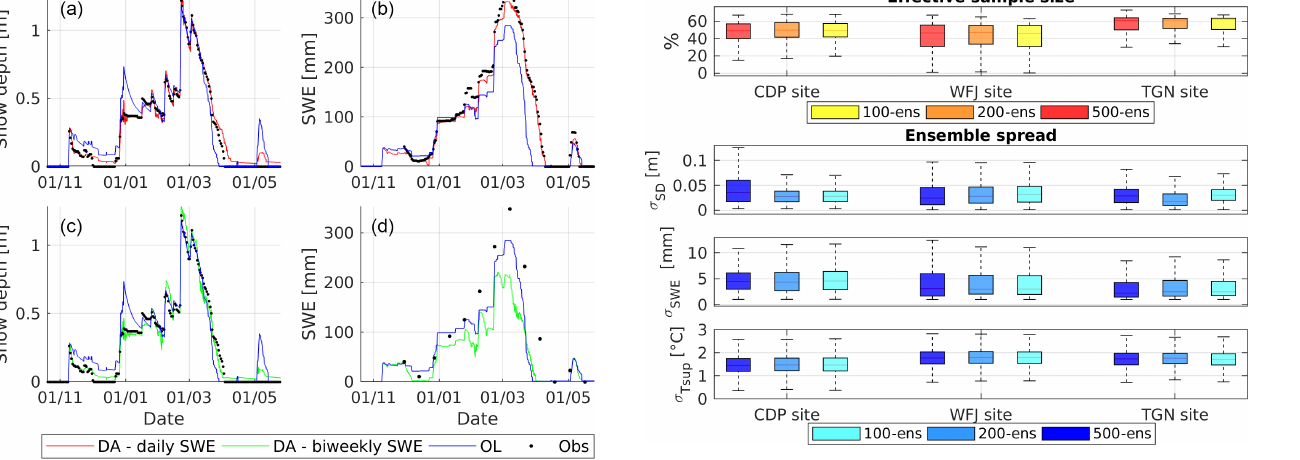
Figure 10. Sensitivity analysis of the multivariate DA scheme to SWE measurement frequency at CDP site, winter 2001/2002. Mean ensemble simulations of snow depth (a, c) and SWE (b, d) for daily (a, b) and biweekly (c, d) SWE measurements.